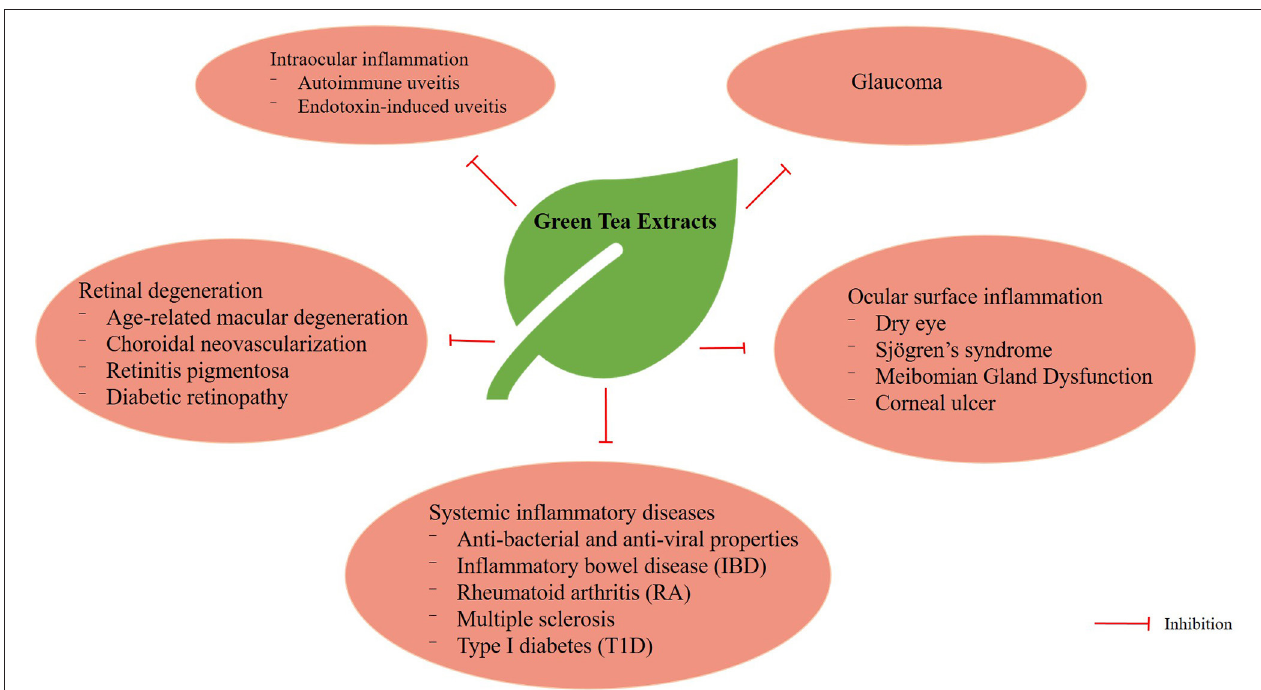
FIGURE 3 | Multiple functions of GTE in various ocular and systemic inflammatory